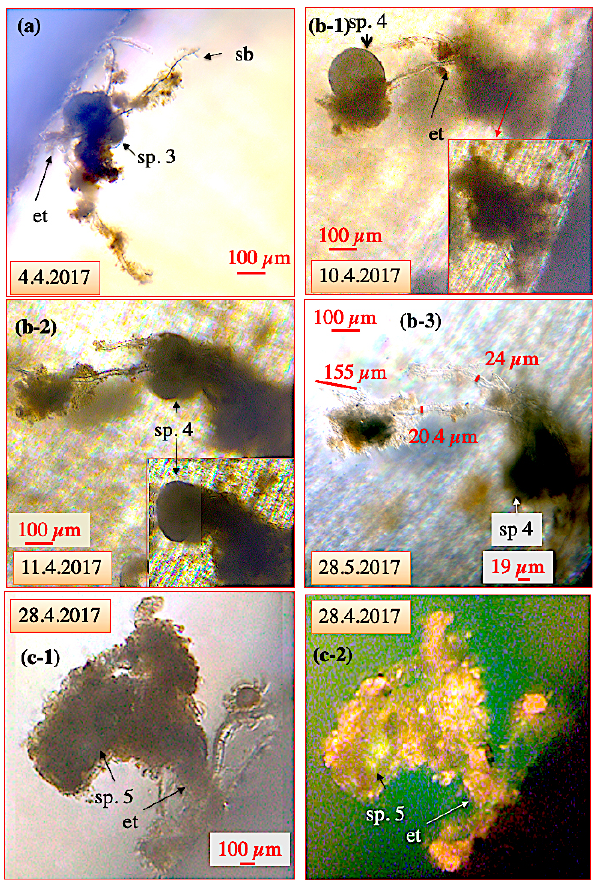
Figure 6. Ectoplasmic trees of C. pachyderma . (a) Ectoplasmic tree of C. pachyderma specimen (sp.) 3 with three thick branches origi- nating from a single “stem” fixed to the aquarium wall. Cibicidoides pachyderma sp. 3 was positioned approx. 100µm away from the wall with no contact to the bottom of the aquarium. (b-1–b-3) Ec- toplasmic tree of C. pachyderma sp. 4 fixed to the aquarium’s bot- tom and extending at least 2mm into the water column. (b-1) On 10 April, specimen 4 had climbed to the top of the ectoplasmic tree. (b-2) The next day, the specimen had moved to the middle section of the ectoplasmic tree. Panel (b-3) shows, as an example, speci- men 4 at the bottom of the ectoplasmic tree on 28 May. Further- more, thickness measurements on the tree structures are provided. (c-1–c-2) Ectoplasmic tree of C. pachyderma sp. 5. Algae adhering to the adhesive side branches of the ectoplasmic tree obscure the ectoplasmic nature when viewed under normal light (c-1) . Panel (c- 2) shows the same ectoplasmic tree under fluorescent light, allow- ing a better visibility of the tree and the specimen’s position. The bright greenish calcein fluorescence of the cytoplasm illustrates the elevated position of specimen 5 within the accumulated algae. “et” denotes ectoplasmic tree; “sb” denotes side branches.